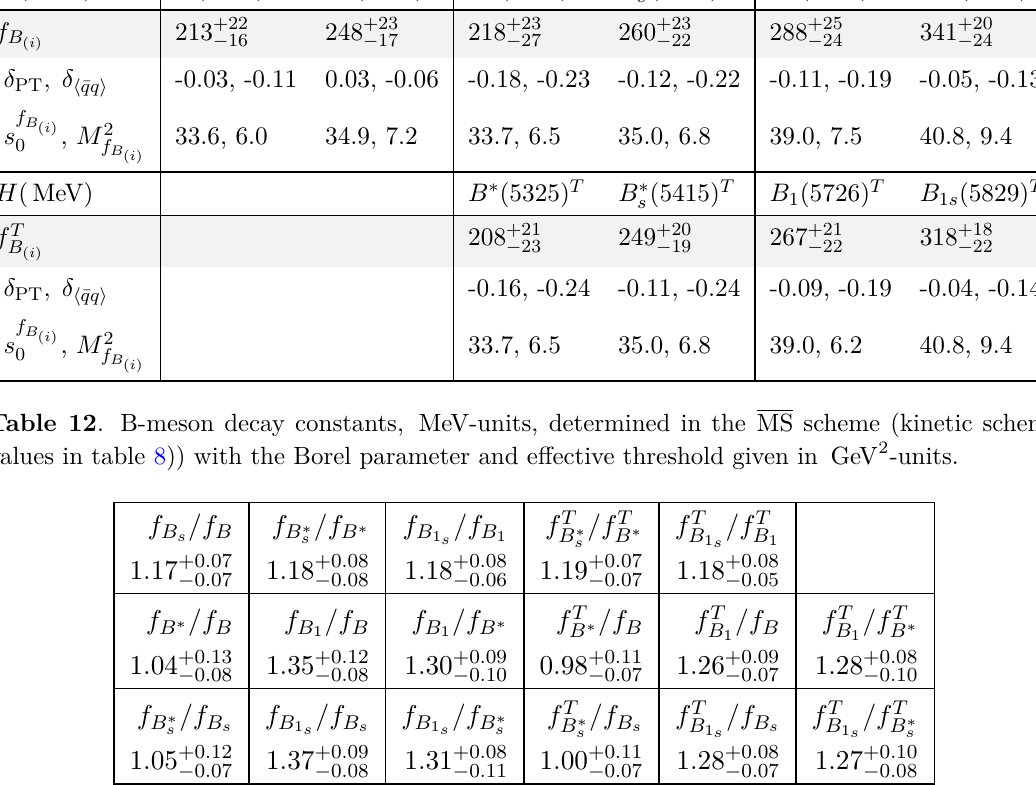
Table 13 . Ratios of decay constants in the MS scheme. The asymmetry of the uncertainty, most pronounced in the pseudo-scalar vs. vector vs. tensor channels, arises from an asymmetric variation of the MS scale, cf. table 1. The corresponding ratios in the kinetic scheme are given in table 10 which are compatible within